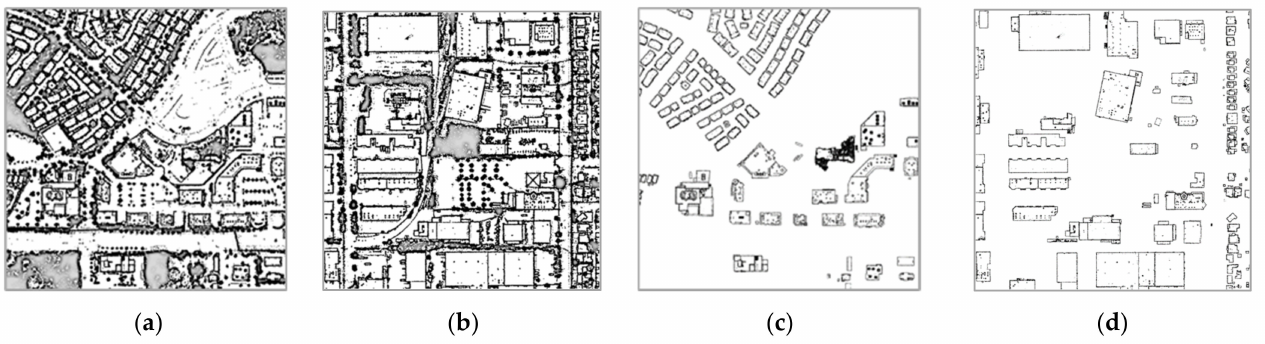
Figure 12. DALES data with two returns: ( a ) test 1; ( b ) test 2. Two returns belong to building boundaries: ( c ) test 1; ( d ) test 2.